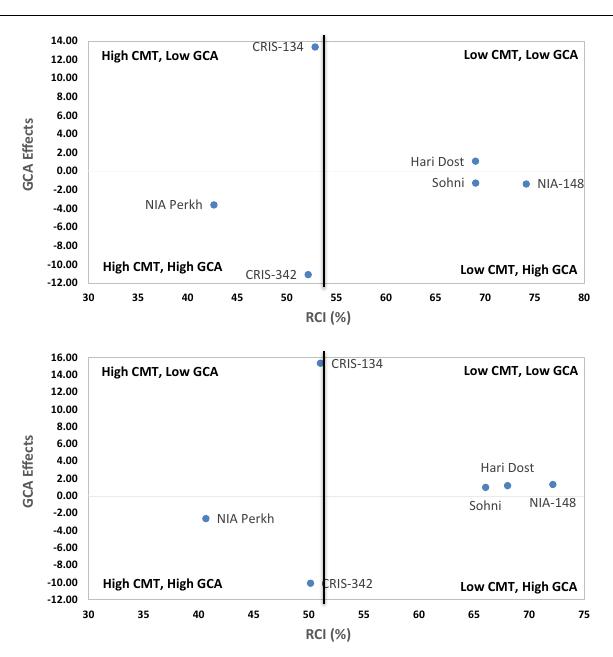
FIGURE 5 | Scatter diagram between RCI% and general combining ability (GCA) effects in upland cotton genotypes (parents) in the glasshouse (up) and field (down) data based on F 1 generation.